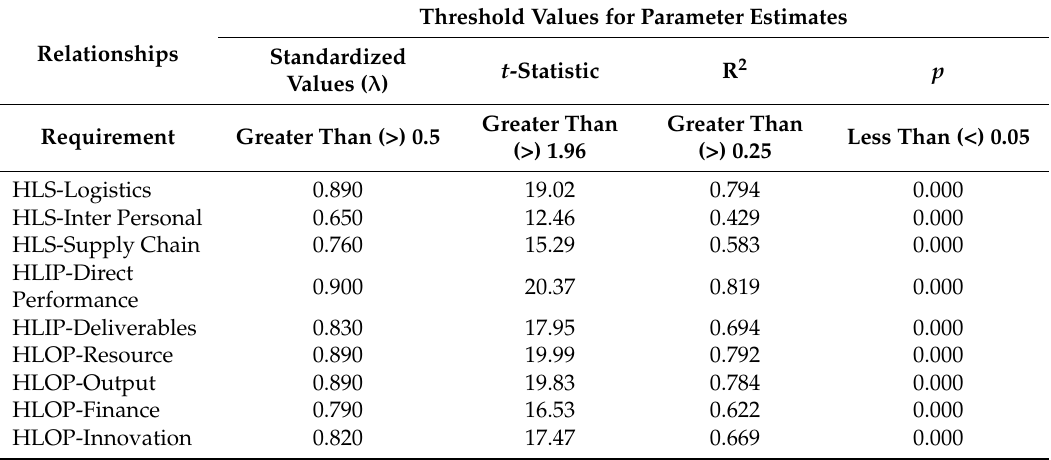
Table 10. Parameter estimates (standardized coefficients) on Factor Analysis.